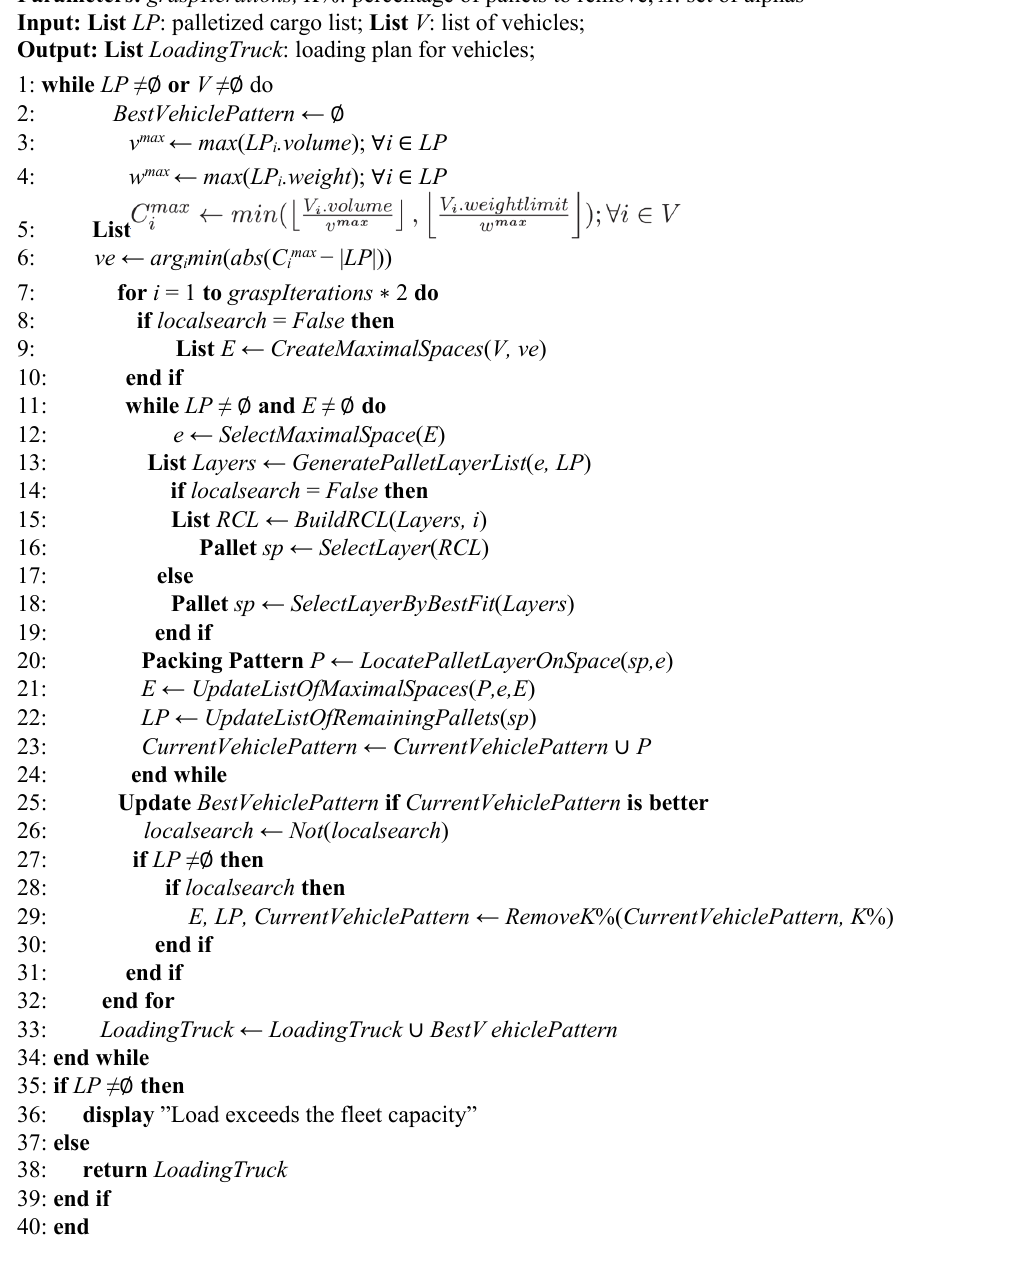
Algorithm 4 GRASP algorithm for Truck